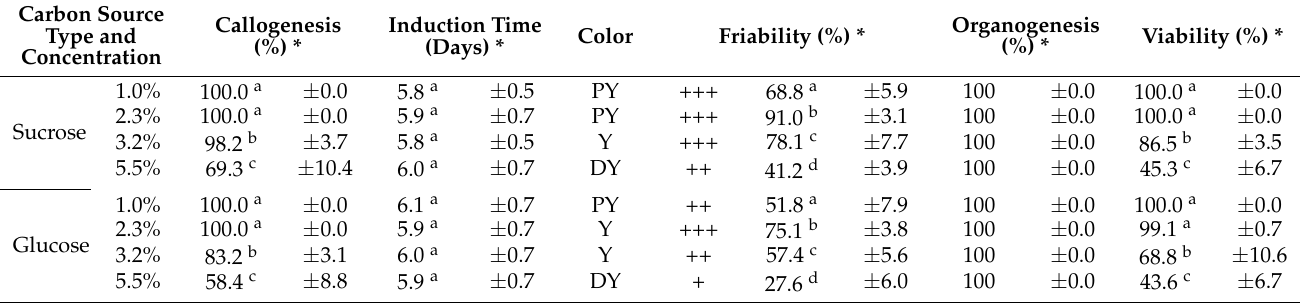
Table 3. Developmental and morphological parameters of T. officinale callus derived from hypocotyls two weeks after induction under different carbon source types (sucrose and glucose) and concentrations (1.0%, 2.3%, 3.2%, and 5.5%) (me- dium MS supplemented with 0.1 mg/L of NAA and 2.0 mg/L of BAP, at 18 ± 2 °C and 0/24 h light/dark). Carbon Source Type and